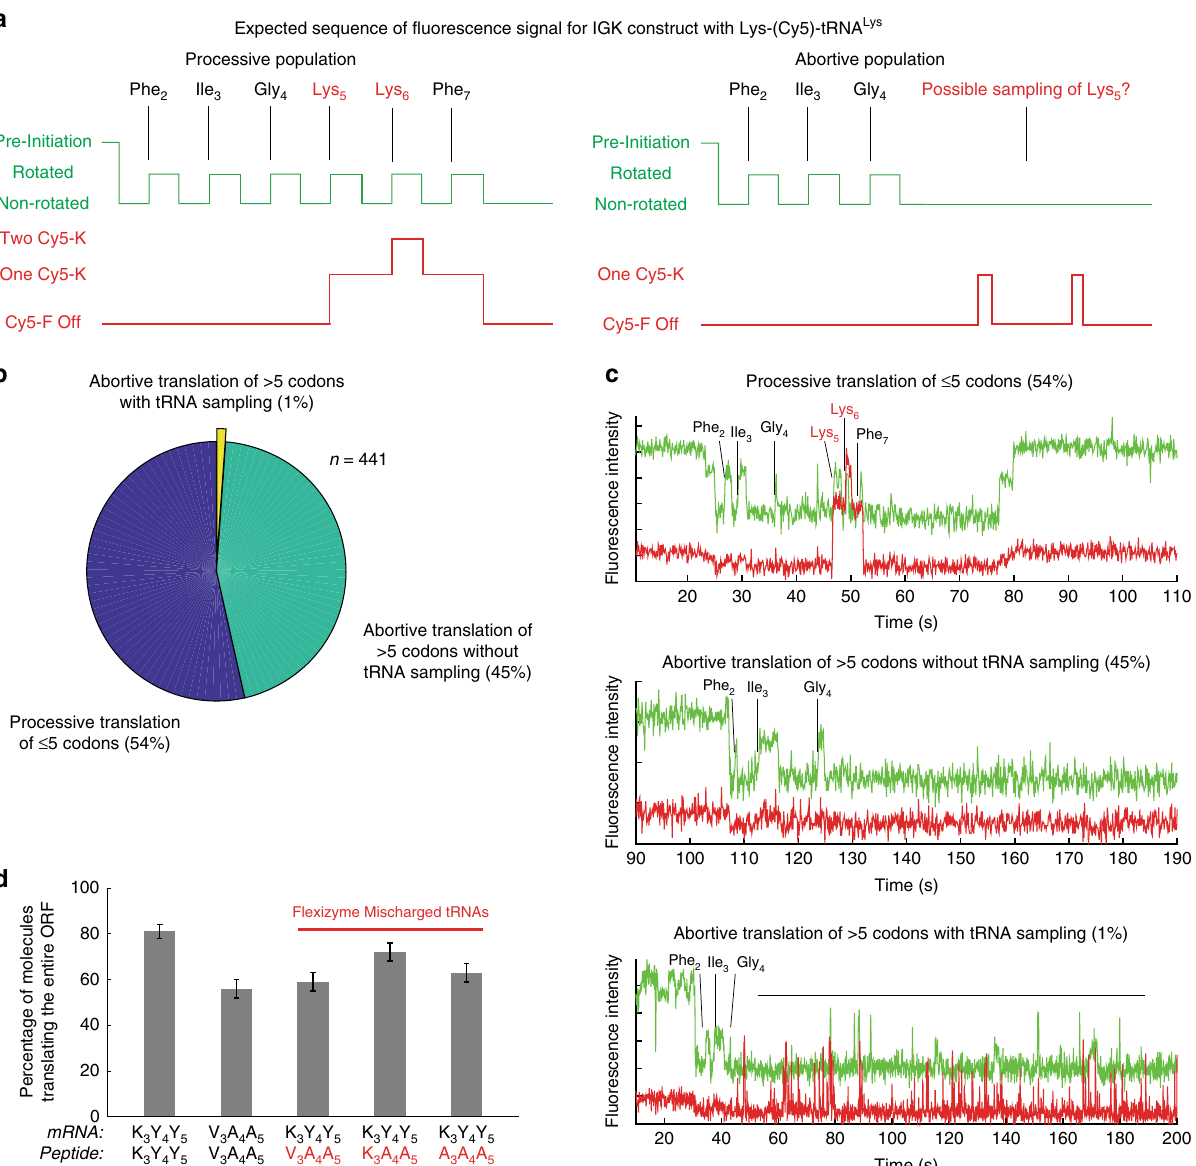
Fig. 8 Parsing tRNA and amino acid contributions to abortive translation of codon 3 – 5. a Expected fl uorescence traces for successful and abortive translation. A possible sampling of tRNA to the A site may occur on the arrested ribosomal population, resulting in multiple binding event of Cy5-labeled speci fi c tRNA such as Lys-(Cy5)-tRNA Lys . b A pie-chart of different populations observed in the experiment. c Representative traces for each population. d Measured percentage of complete translation events for K 3 Y 4 Y 5 and V 3 A 4 A 5 mRNA codons with a correct peptide, and for translating K 3 Y 4 Y 5 mRNA codons with